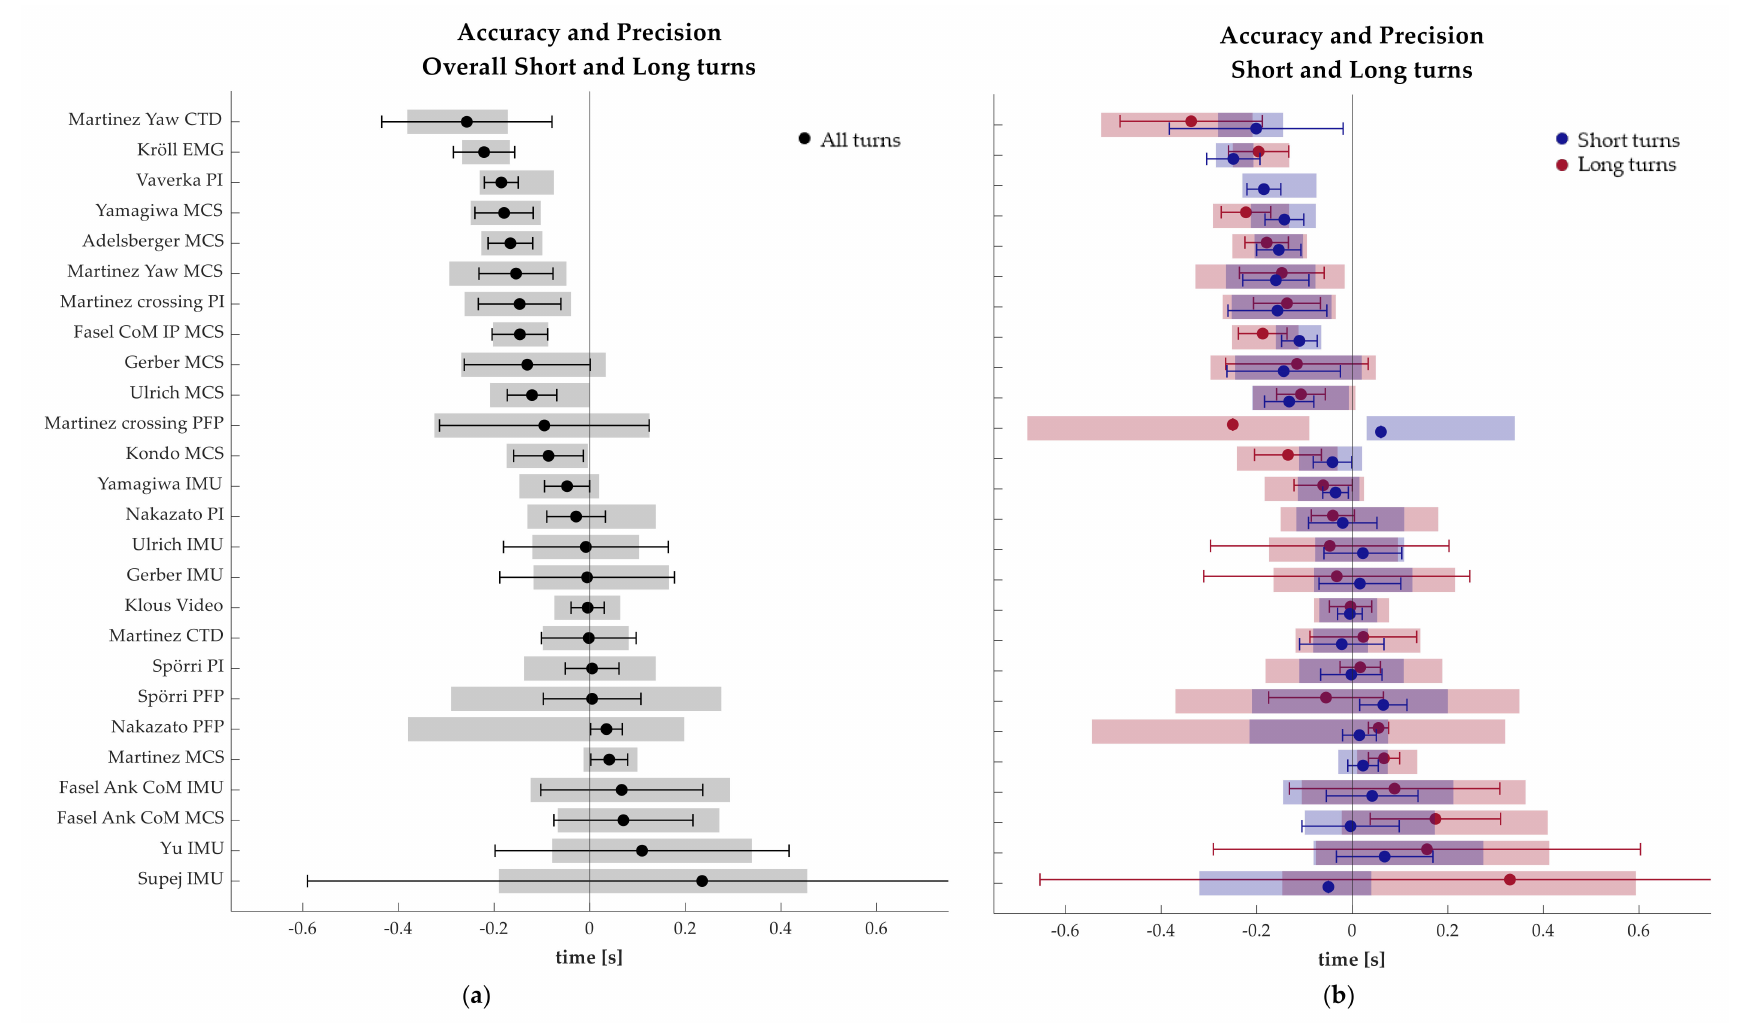
Figure 3. Timeline depicting the accuracy and precision of the turn switch detection methodology. The left side ( a ) figure shows the accuracy (black dot), standard deviation of the accuracy (whiskers) and precision (shaded area) of every method calculated with all turns pooled together. The right side ( b ) graph separates the data by turn size, long turns (red) and short turns